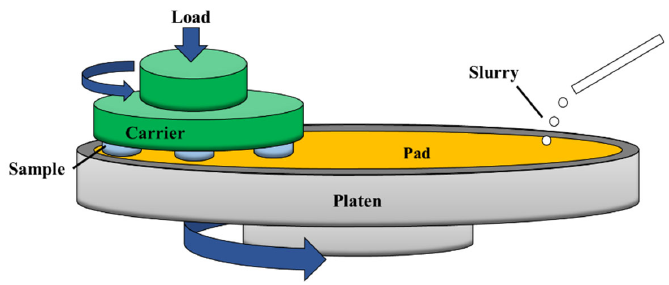
Figure 1. Polishing schematic